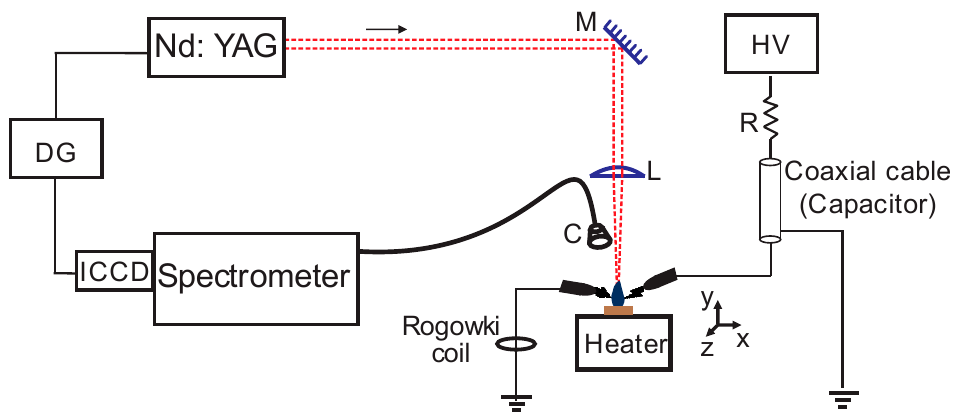
Figure 1. Experimental arrangement employed for HV ‐ LIBS on preheated targets. Keys: L: lens; R: resistance; M: mirror; C: collimator; DG: pulse/delay generator; HV: high voltage power supply.